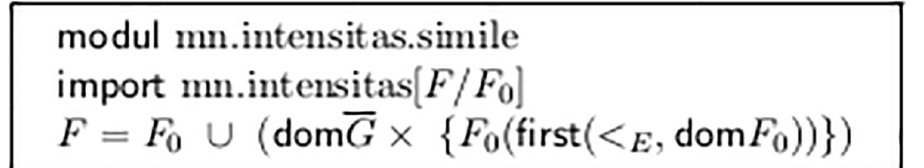
Fig 15. Alternative, very different